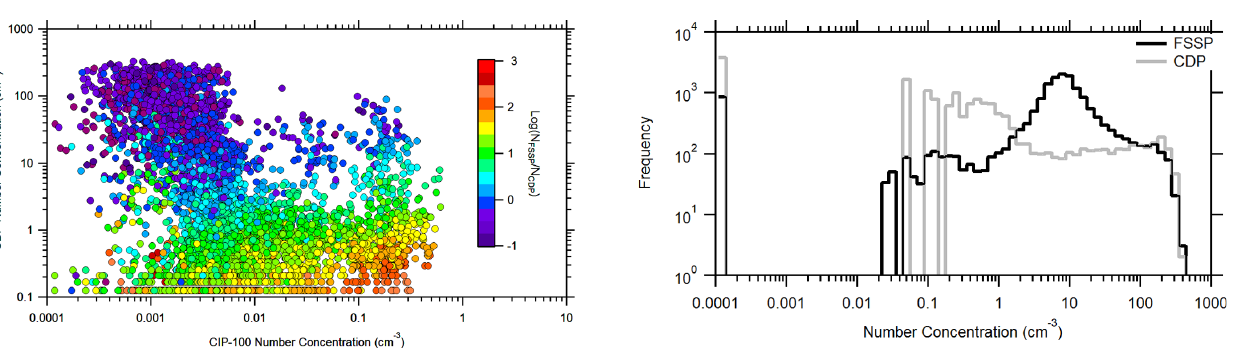
Fig. A1. CDP total number concentration as a function of CIP-100 total particle number concentration. Data are from flight B434 in a large frontal system. Data are coloured to the log 10 of FSSP:CDP total number concentration ratio.